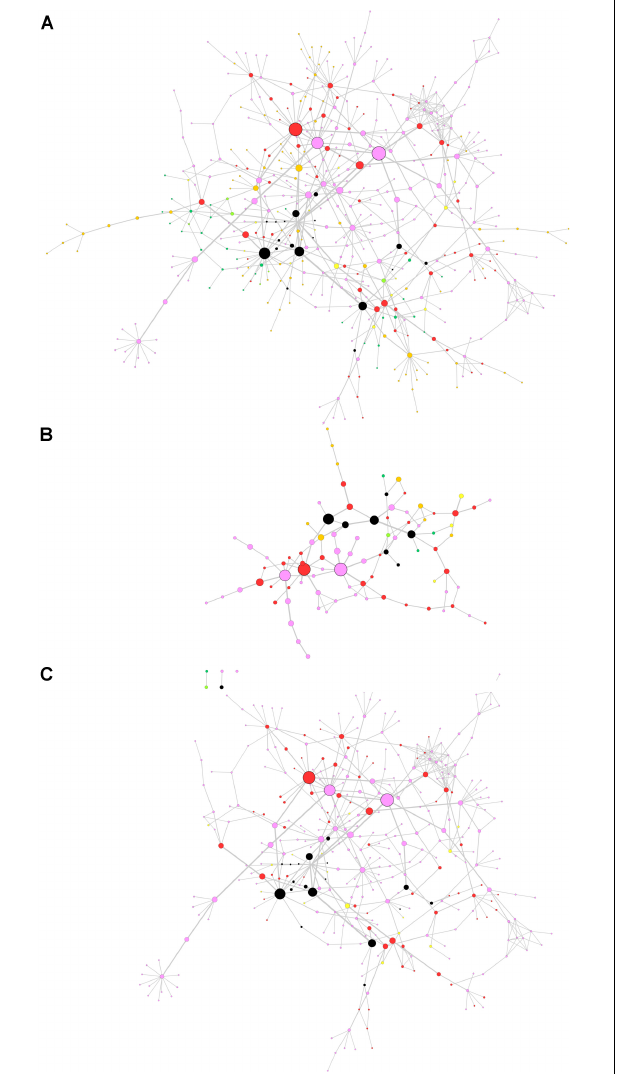
FIGURE 4 | Topological analysis of the proteomics neurodegeneration network from secondary data analysis. (A) Whole network; (B) top 20% most central nodes; (C) selection from the whole network of nodes altered in Parkinson’s disease (PD) patients. Nodes are color-coded as follows. Pink, PD; dark green, amyotrophic lateral sclerosis (ALS); orange, Alzheimer’s disease (AD); yellow, PD and ALS; light green, ALS and AD; red, PD and AD; black, PD, ALS and AD (adapted from Monti et al., 2018). Node size and border width are proportional to betweenness centrality, whereas edge width is proportional to edge